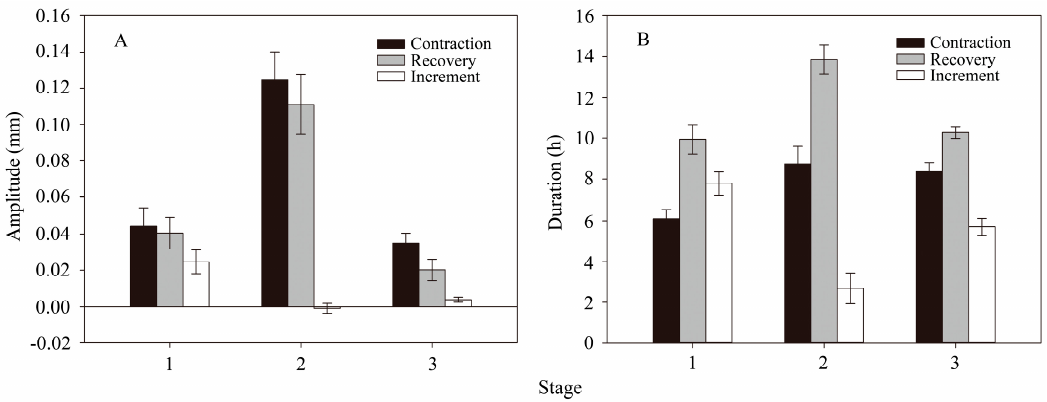
Figure 5. Mean amplitude ( A ) and duration ( B ) of contraction, recovery, and increment phase of four trees in three stages. Values are means ± standard error ( n = 4).